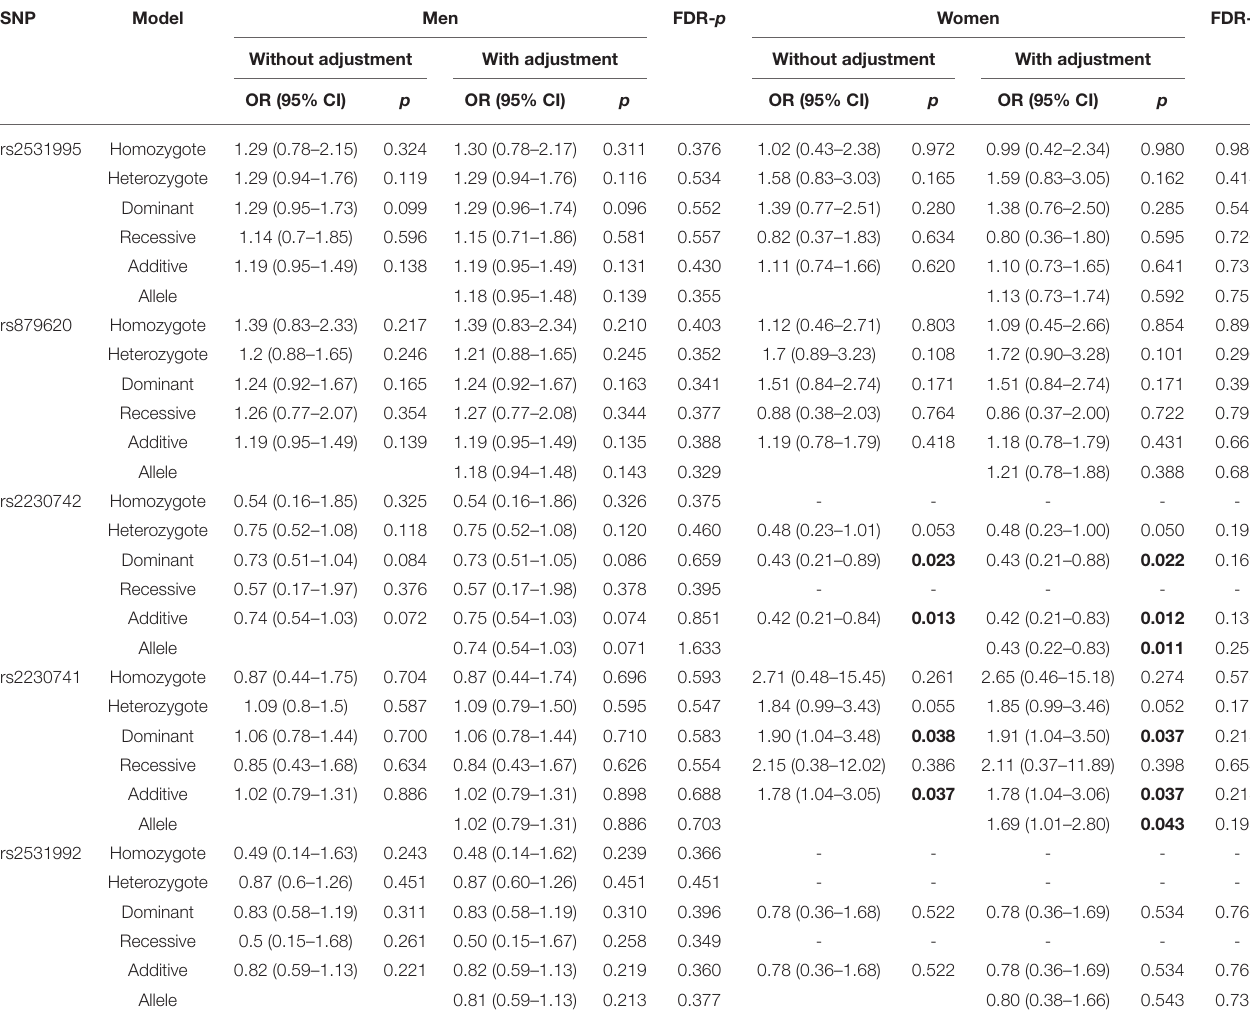
TABLE 5 | The association between ADCY9 gene polymorphisms and hepatocellular carcinoma risk in subgroup of gender. SNP